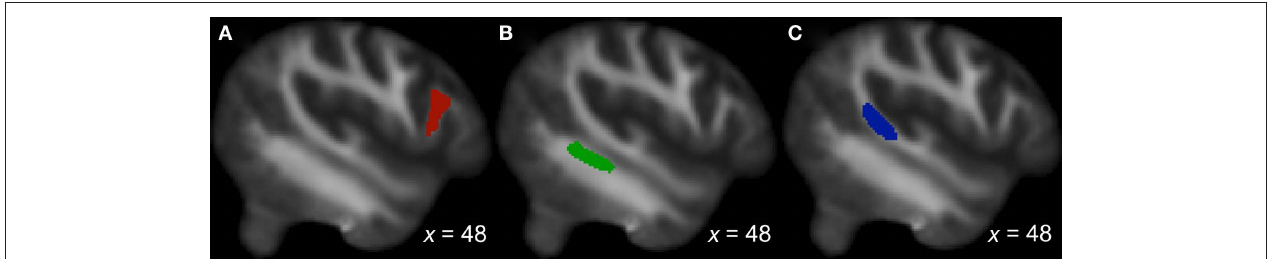
Figure 1 | region of interest locations displayed on the FA images: (A) iFg, (B) MTg, (C)